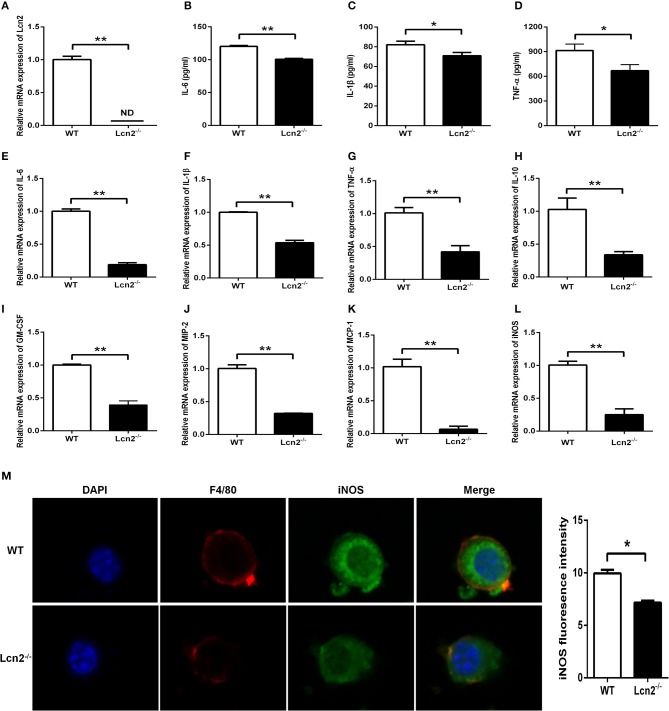
Decreased expression of inflammatory cytokines produced by lipocalin 2-deficient (Lcn2−/−) macrophages. (A) Real-time PCR analysis of Lcn2 mRNA expression levels in the E. coli O157:H7-infected primary bone marrow-derived macrophages (BMDMs) from wild-type (WT) and Lcn2−/− mice. (B–D) ELISA analysis of interleukin (IL)-6, IL-1β, and tumor necrosis factor (TNF)-α levels in the culture medium of the E. coli O157:H7-infected BMDMs from WT and Lcn2−/− mice. (E–L) Real-time PCR analysis of cytokine mRNA expression levels in the E. coli O157:H7-infected pBMDMs from WT and Lcn2−/− mice. (M) The infected BMDMs of WT and Lcn2−/− mice were subjected to staining with rabbit monoclonal antibody iNOS, rat monoclonal antibody F4/80, Alexa Fluor 488 goat anti-rabbit IgG, and Alexa Fluor 647 goat anti-rat IgG in blocking buffer (1:200) and observed by fluorescence microscopy. Values are average means of triplicate experiments with two mice used for the isolation of BMDMs per genotype per experiment. Error bars depict SEM. Results are expressed as means ± SEM. P < 0.05 was considered statistically significant. *P < 0.05 and **P < 0.01.